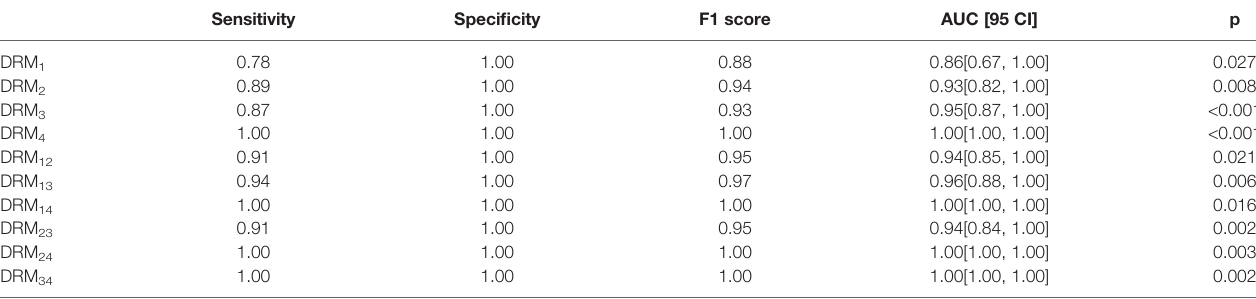
TABLE 2 | ROC results for the tumor voxel dose – response matrix (DRM).